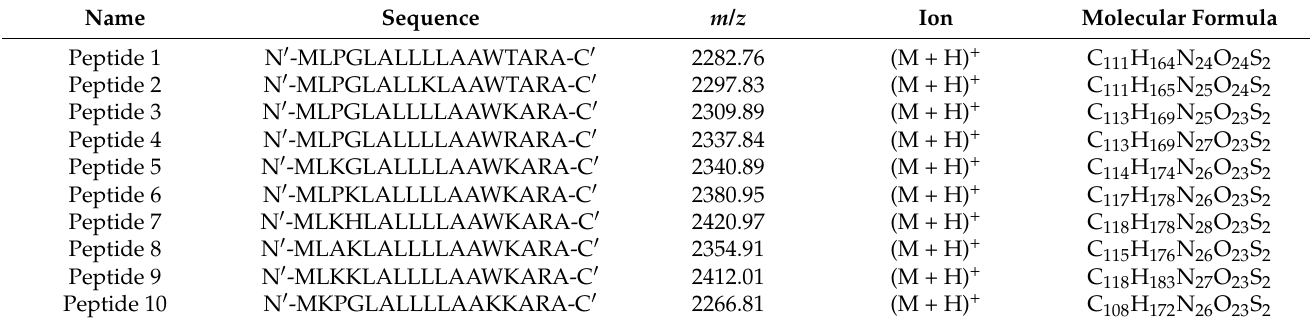
Table 2. Ten CPP-peptide sequences synthesized. Peptide 1 is the WT